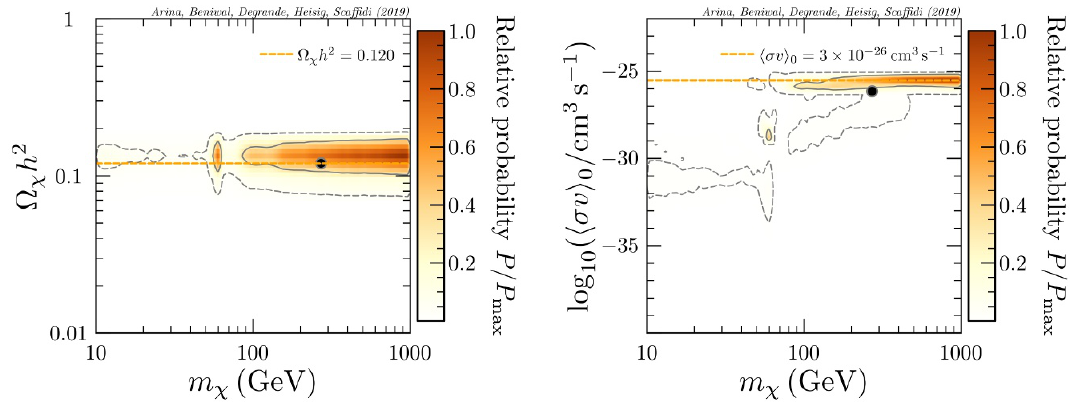
Figure 5 . 2D MP distributions for key DM observables such as the pNG DM relic density ( left panel ) and its annihilation rate today ( right panel ). The meaning of solid (dashed) lines and black circle is same as in (cid:12)gure